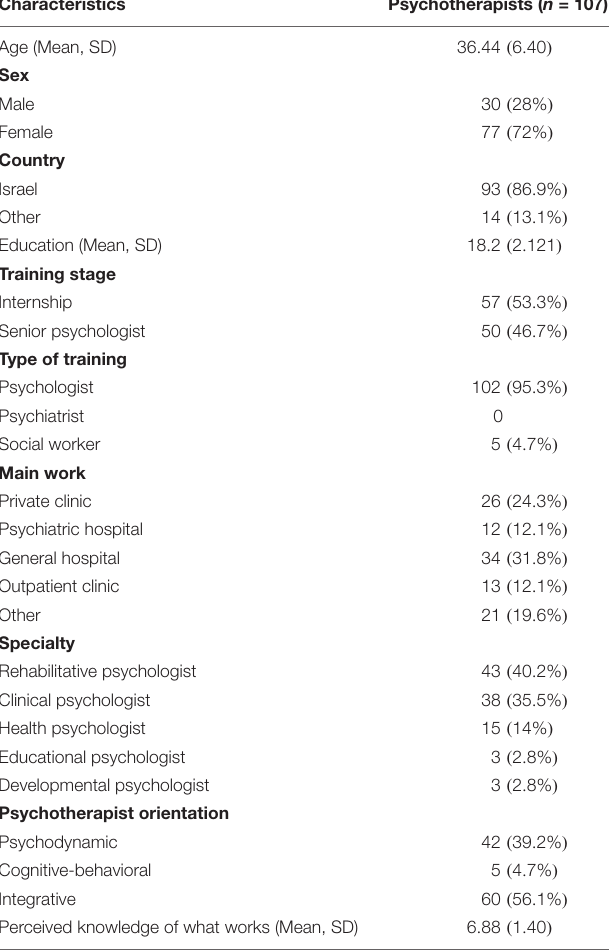
TABLE 1 | Characteristics of the study sample ( n =